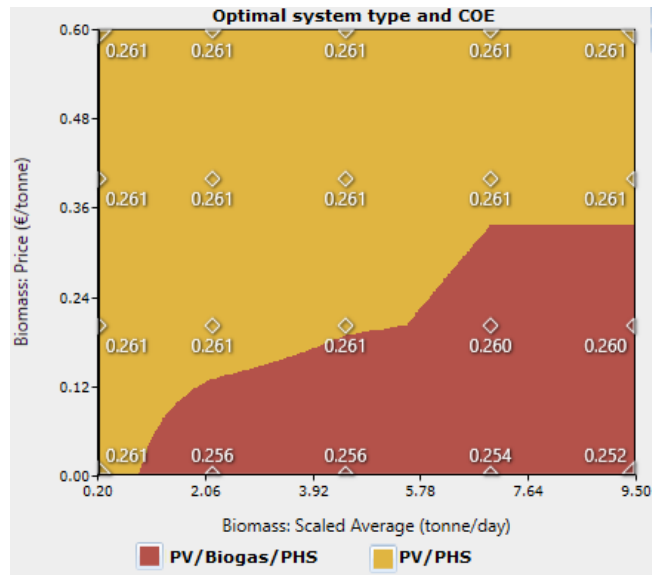
Figure 20. Sensitivity analysis result of the price and availability of biomass.